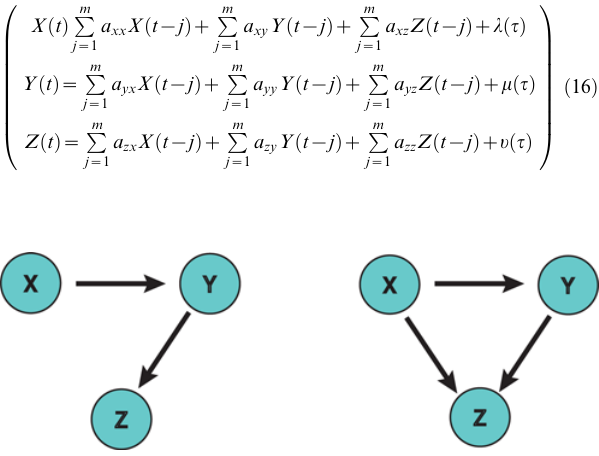
Figure 2. Conditional Pairwise Granger Causality In a Three Neuron Network. If pairwise Granger causality were applied to determine the connectivity of both of these network configurations the results for both would resemble panel a). Using pairwise Granger causality alone, it is not possible to differentiate between these network configurations. Conditional Granger causality is needed to determine if the connection from X to Z is real or mediated through Y by determining how well Z can be predicted by X with versus without